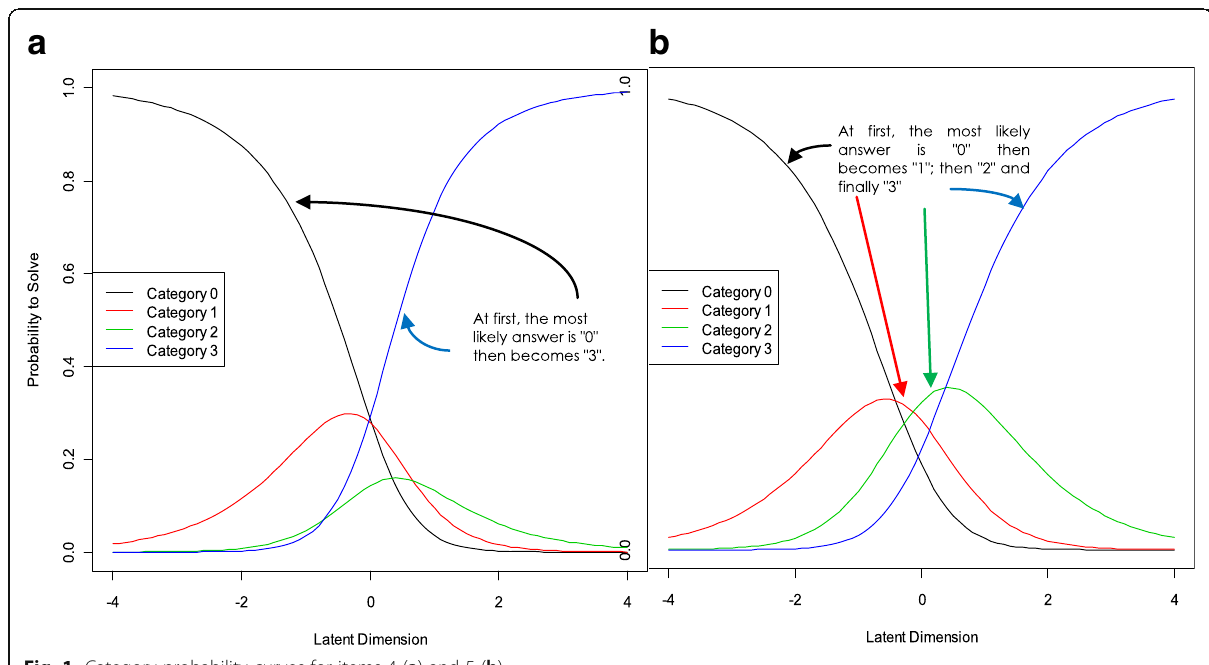
Fig. 1 Category probability curves for items 4 ( a ) and 5 ( b